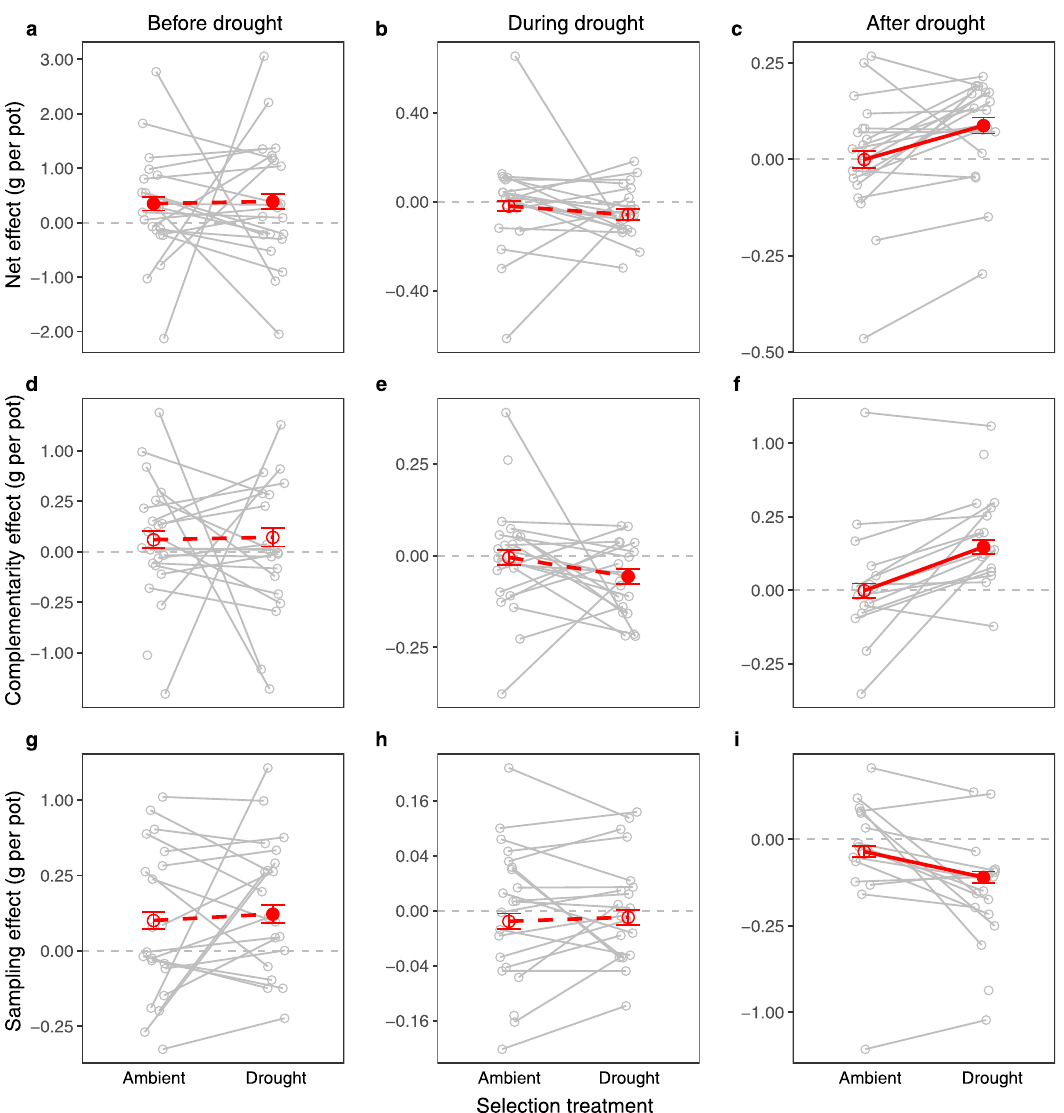
Fig. 2 Difference in biodiversity effects on productivity between selection treatments (ambient- vs. drought-selected plants) before, during, and after the drought event in the glasshouse. Biodiversity effects on productivity were calculated as net effect ( a – c ), complementarity effect ( d – f ), and sampling effect ( g – i ). The solid red lines indicate signi fi cant differences between the two selection treatments (see Table 1). Red points and error bars show means ± standard error of 2-species mixtures of the corresponding selection treatment. The fi lled red points show signi fi cant differences from zero (horizontal dashed lines, see Supplementary Table 3), i.e., positive or negative average biodiversity effects on productivity. Gray points represent means for species pairs (standard errors for species pairs not shown). Gray lines connect the same species pair between the two selection treatments. Source data are provided as a Source data fi le. The numbers of mixtures per species pair (gray points) and per selection treatment (red points) are provided in the Source data fi le and Supplementary Table 3,